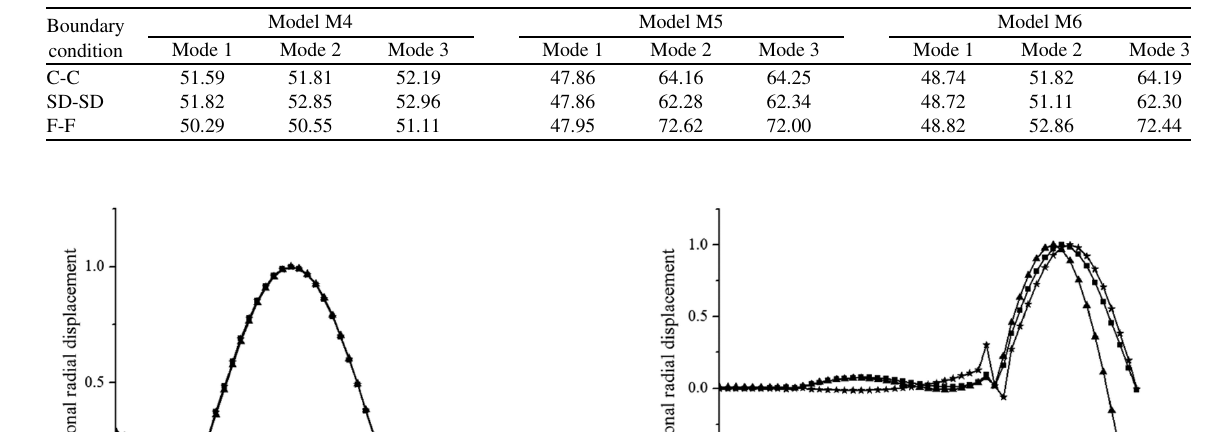
Table 8 Natural frequencies of model M4,model M5 and model M6